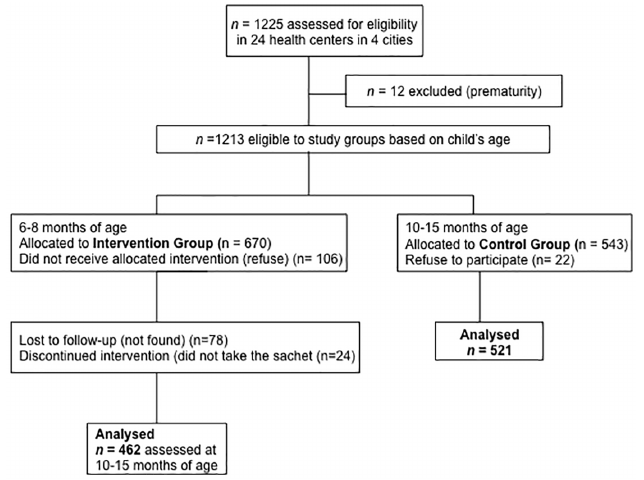
Fig 1. Flow of participants in the ENFAC study. CG, control group; ENFAC, Estudo Nacional de Fortificaç ã o caseira da Alimentaç ã o Complementar ; IG, intervention